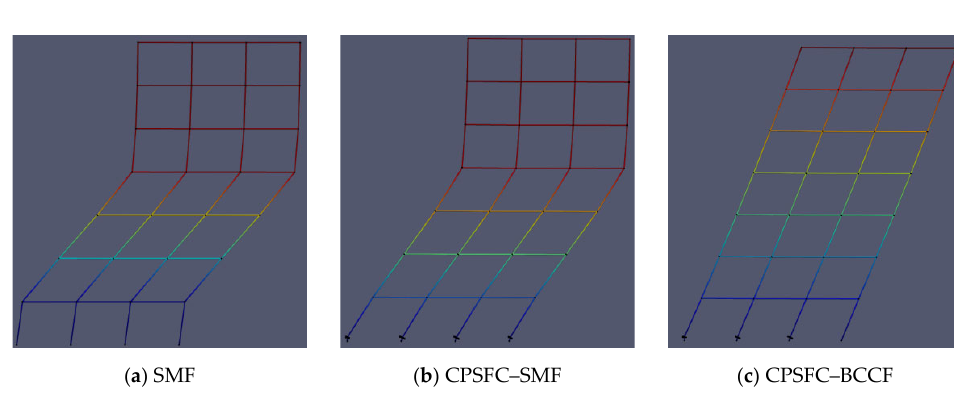
Figure 19. DCF–roof drift ratio curves. 5. Conclusion This paper proposes a BCCF structure system with the low ‐ damage CPSFC at the column bases. The system integrates the concept of continuous columns’ slip ‐ friction con ‐ nections to avoid damage at the first story column bases and changes the failure of the steel moment frame. The study was carried out by using experimental and OpenSees sim ‐ ulation methods. The results of a series of studies were as follows: 1.